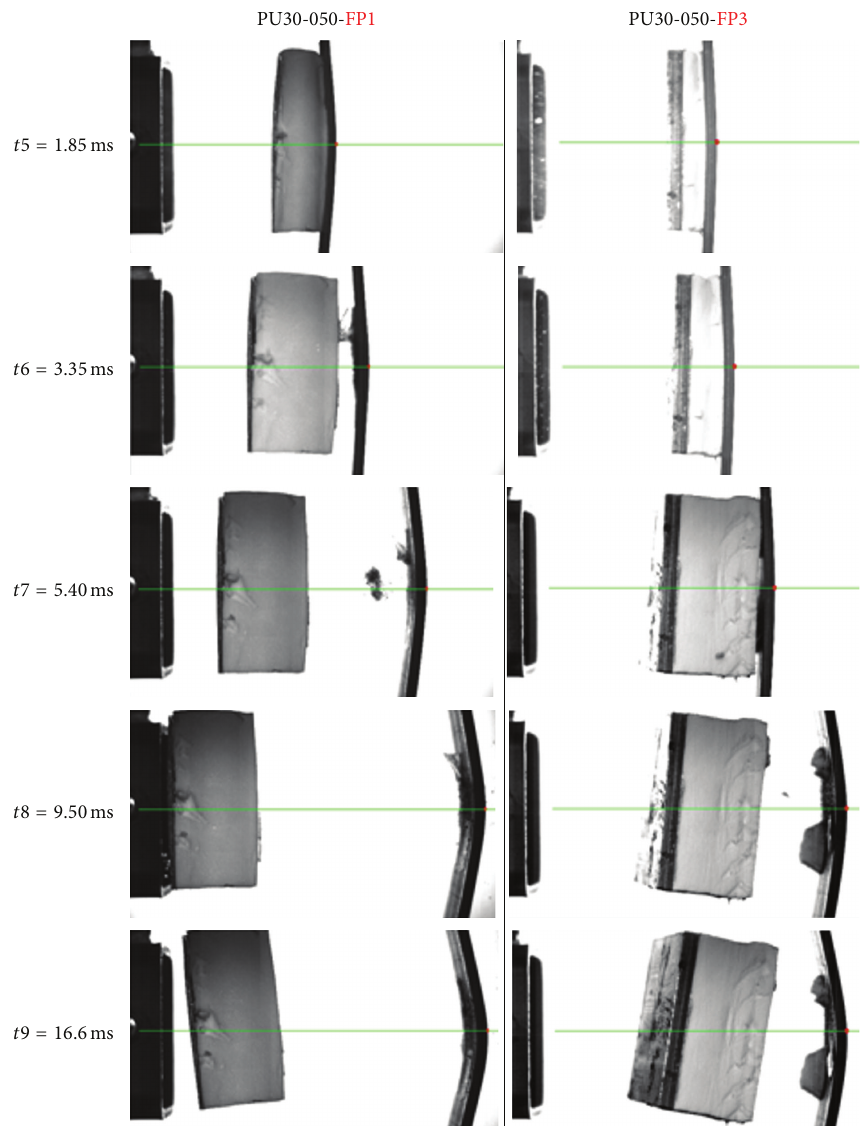
Figure 10: The chronological interaction of the simply supported beam with the tested sacrificial cladding configurations: PU30-050-FP1 and